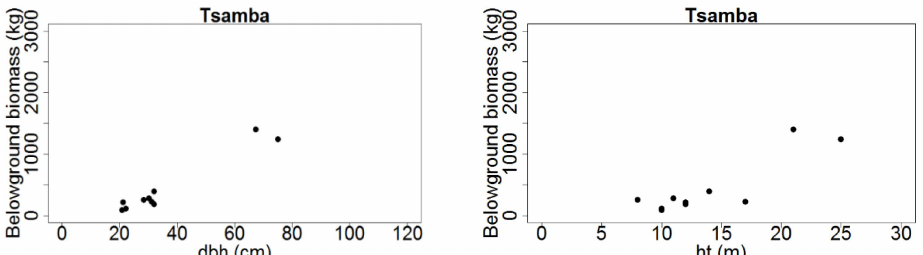
Figure 3. Total belowground tree biomass (kg dry weight) distribution over dbh (cm) and ht (m) for Mtangatanga, Kongwe, Mua-livulezi and Tsamba and forest